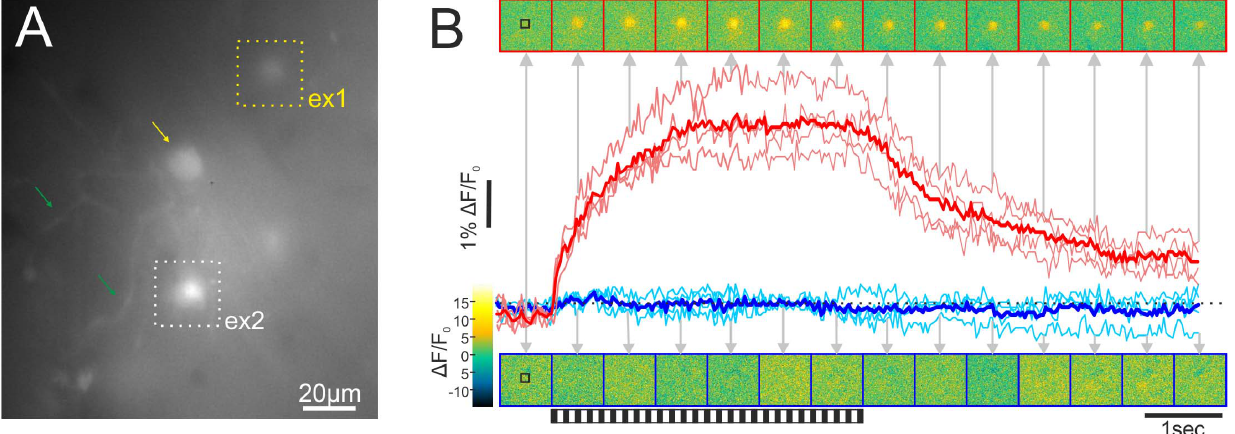
Figure 3. Recording of somatic calcium signals in the optic tectum of adult zebrafish. A. Top view on the exposed tectum, showing several somata (yellow arrow) and some dendrites (green arrows). Note that not all aspects of the labelled neurons are in focus, since this is the view based on the experimental focus on the soma indicated by the white dotted square (ex2). Another soma, depicted by the yellow dotted square (ex1), yielded the calcium responses shown in panel B. B. Example of the responses to the preferred (45 u , red trace) and a non-preferred (180 u , blue trace) motion direction of the soma shown in A (ex1, yellow dotted square). Pink and light blue traces show the single repetitions (4 per direction) and the red and dark blue traces show the mean. Single colour-coded images showing the time course of the fluorescence change are depicted at the times indicated by the grey arrows. The first image shows the fluorescence before the pattern starts to move. Every following picture shows the fluorescence in steps of 20 frames. Stimuli lasted four seconds and the stimulus start and end are depicted by the striped pattern below the images. The time courses show the relative fluorescence changes ( D F/F 0 ) averaged over the pixels within a rectangular ROI (indicated as black square in the first image of each series). Baseline fluorescence (F 0 ) was determined by averaging across the first 5–20 recorded frames of the series.